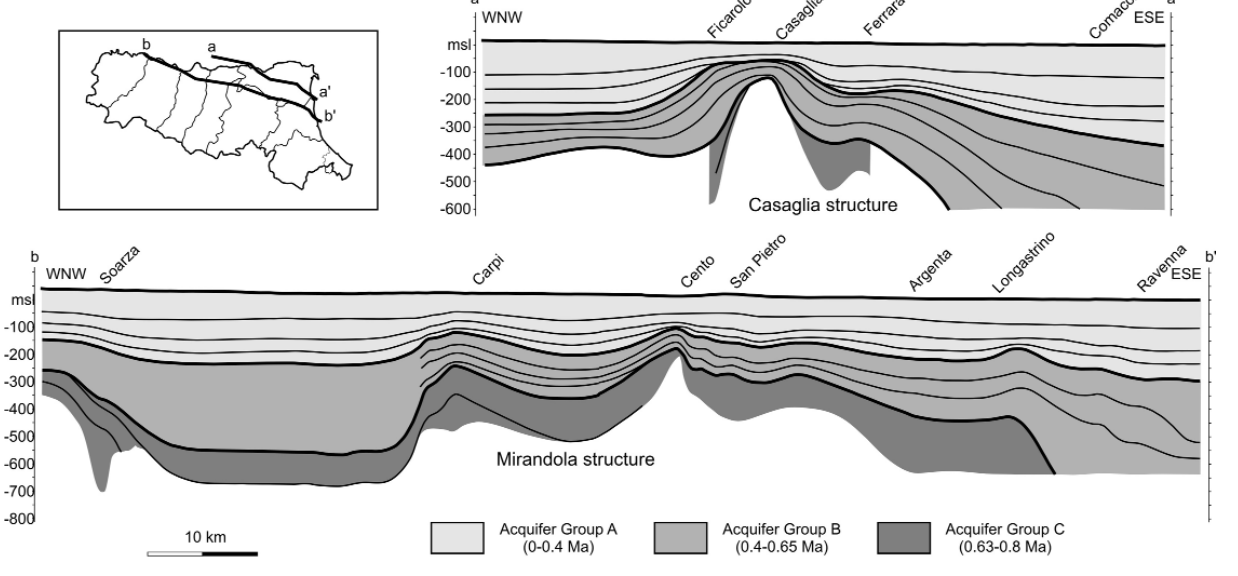
Figure 2. Hydro-geological sections running in the WNW-ESE direction, through (a-a') the Casaglia structure (Ferrara); and (b-b') the Mirandola struc- ture (Modena) (modified after Pieri and Groppi [1981]). Both sections show the main aquifer bodies corresponding to the Middle-Upper Quaternary lithostratigraphic units that mainly consist of alluvial and shallow-water marine deposits that progressively infilled the Po River foreland basin (modified after Regione Emilia-Romagna and ENI-AGIP